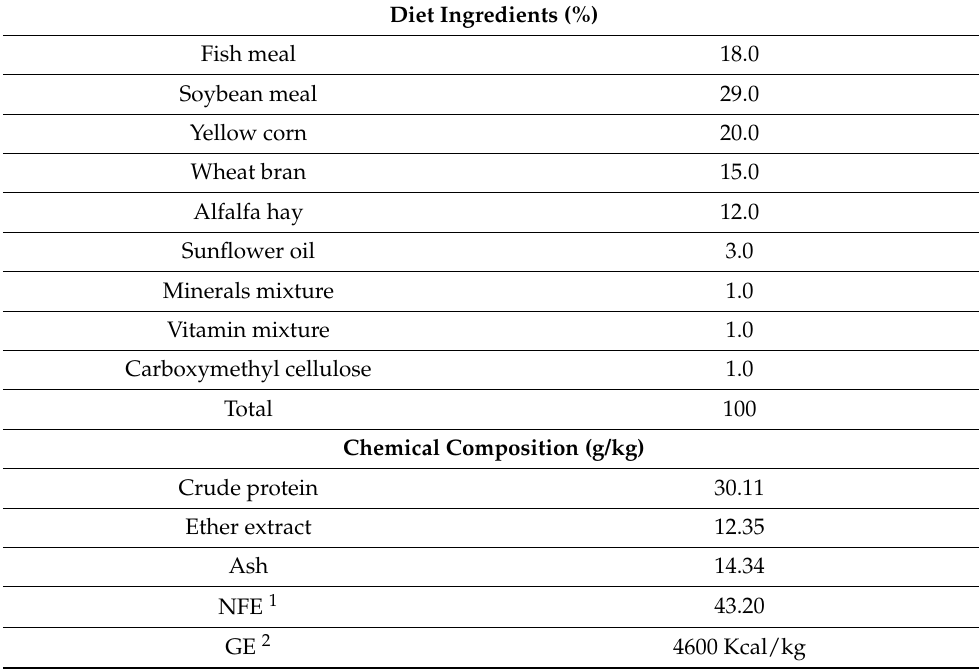
Table 1. Diet formulation and proximate analysis